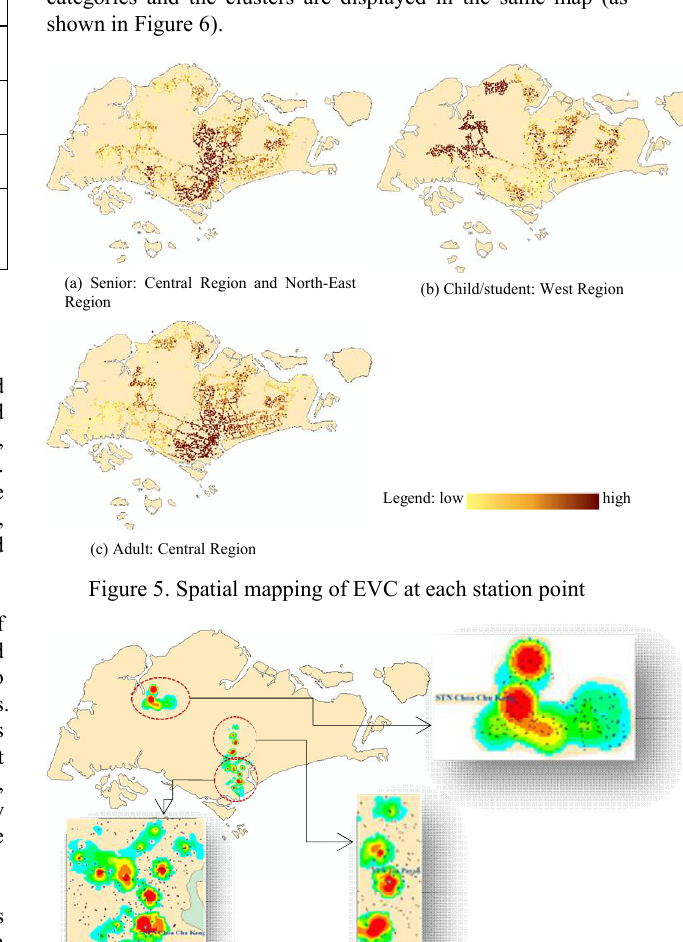
Figure 6. Interpolated EVC landscape for the three categories